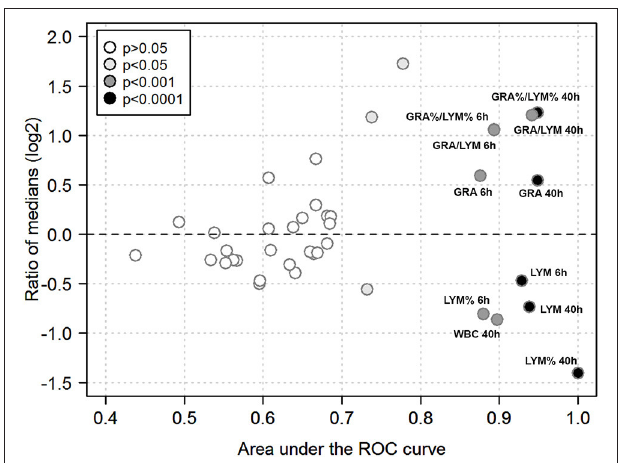
FIGURE 7 | Quantitative biomarker evaluation of peripheral blood cell indices. The analysis is based on the data used for Figures 5 , 6 using absolute and relative values of the hematological indices outlined in Methods. Each symbol corresponds to one blood cell parameter and time point. Ratios of medians of all paired group comparisons (“fold change” of a given parameter in AP1 infection / 5448 infection at a given time point) are plotted along the y-axis (log 2 -scale), the area under the ROC curve along the x-axis, and the asymptotic significance of the ROC curve (significance cut-off = P ≤ 0.05) as the fill color. Blood cell parameters of particular interest are identified by labels. Same abbreviations as in Figures 6 except that a % denotes use of a relative cell count, i.e., the absolute count of the respective cell type divided by WBC